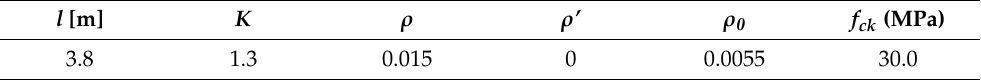
Table 5. Beams dimension for first case of study ( h , b , As , As’ values in m and cm 2 ).